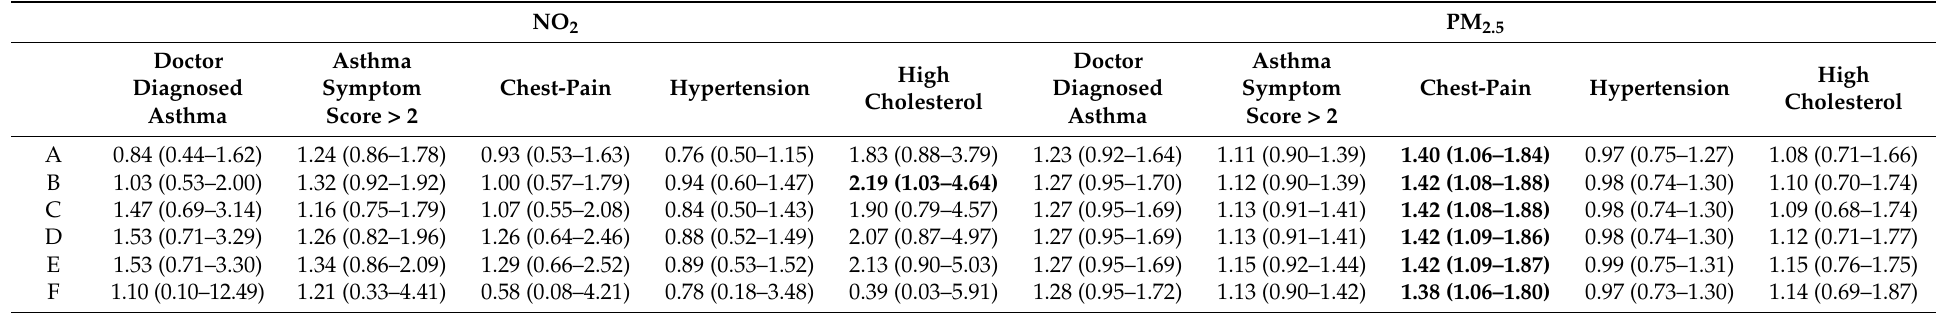
Table 5. Association between interquartile increase in estimated annual NO 2 and PM 2.5 levels and self-reported cardiorespiratory outcomes in two-pollutant model, reported as odds ratios (95% confidence